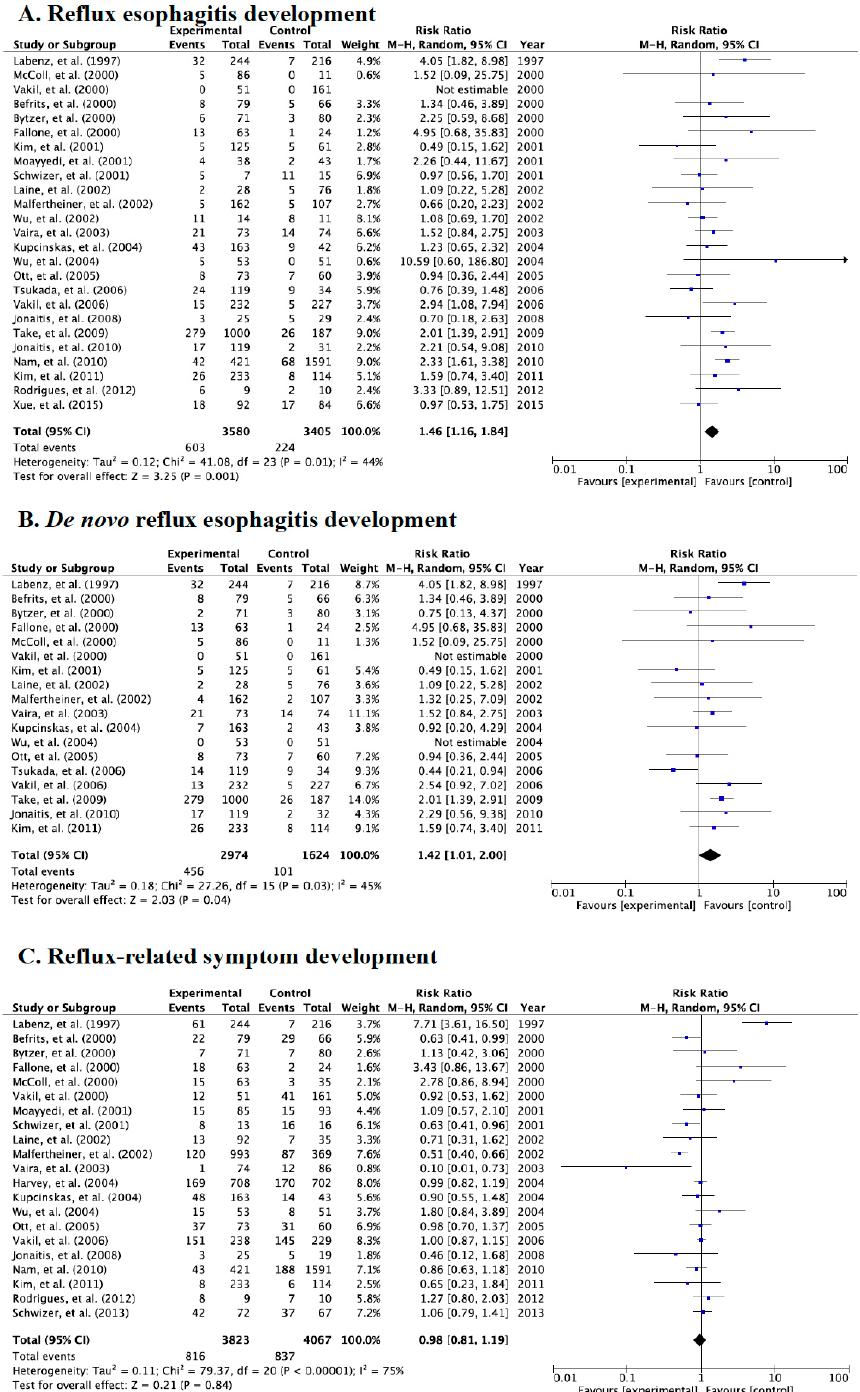
Figure 2. Forest plots of the rate of patients with reflux esophagitis development after eradication irrespective of whether they were free from gastroesophageal reflux disease (GERD) at baseline ( A ), the rate of de novo reflux esophagitis newly developed after eradication ( B ) and the rate of patients with reflux-related symptoms after eradication therapy ( C ) in a random-effects model. Significant differences in reflux esophagitis and de novo esophagitis were shown between patients receiving eradication therapy and those receiving placebo. Abbreviations: CI, confidence interval.